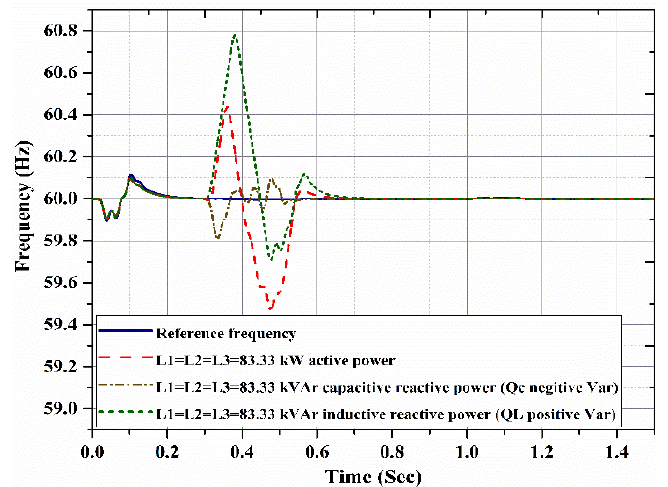
Figure 11. The frequency variations during islanding conditions of scenario 1 for different configurations of the connected feeder